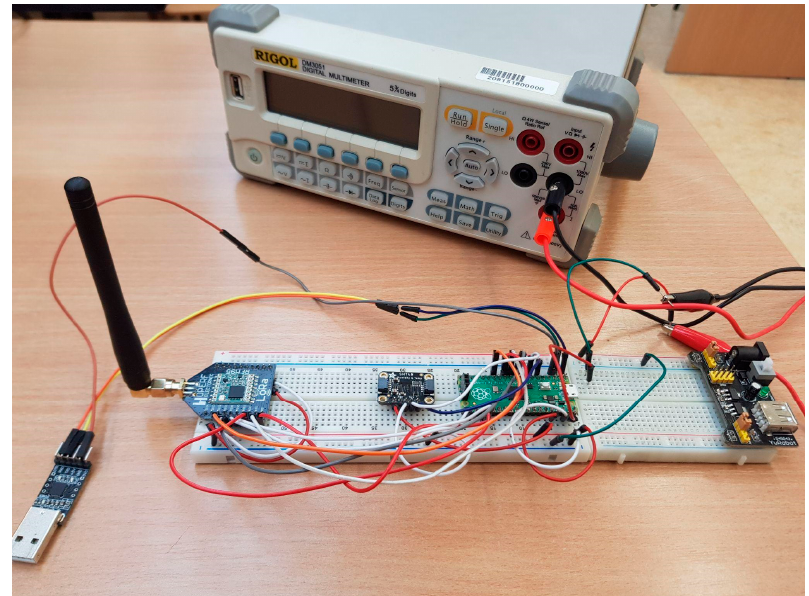
Figure 7. Laboratory set with measuring instruments (own source).